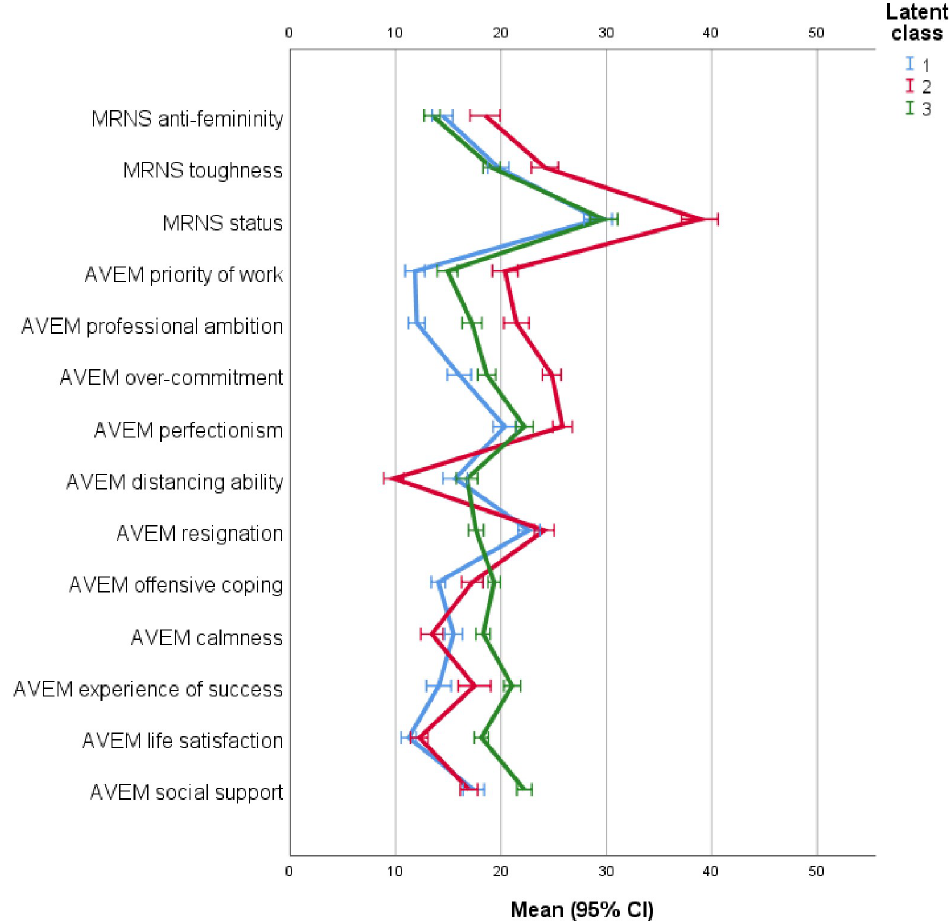
Fig 1. Latent class profile for masculinity norms and work role orientations. Means and 95% confidence intervals.